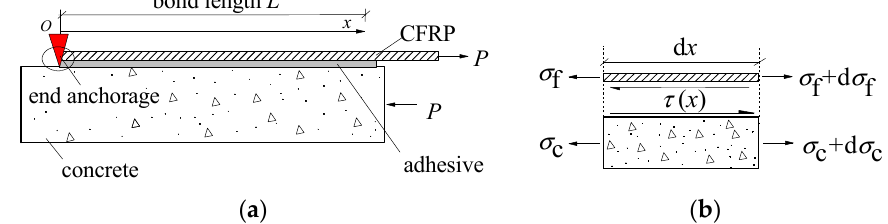
Figure 1. Single-lap shear test of CFRP-to-concrete bonded joints with end anchorage: ( a ) single-lap shear tests model; ( b ) Development of stress in CFRP–concrete joint.